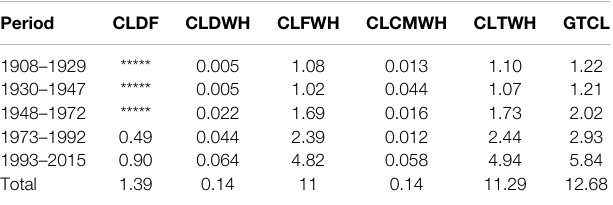
TABLE 3 | Carbon emissions (million tons) related to deforestation and wood